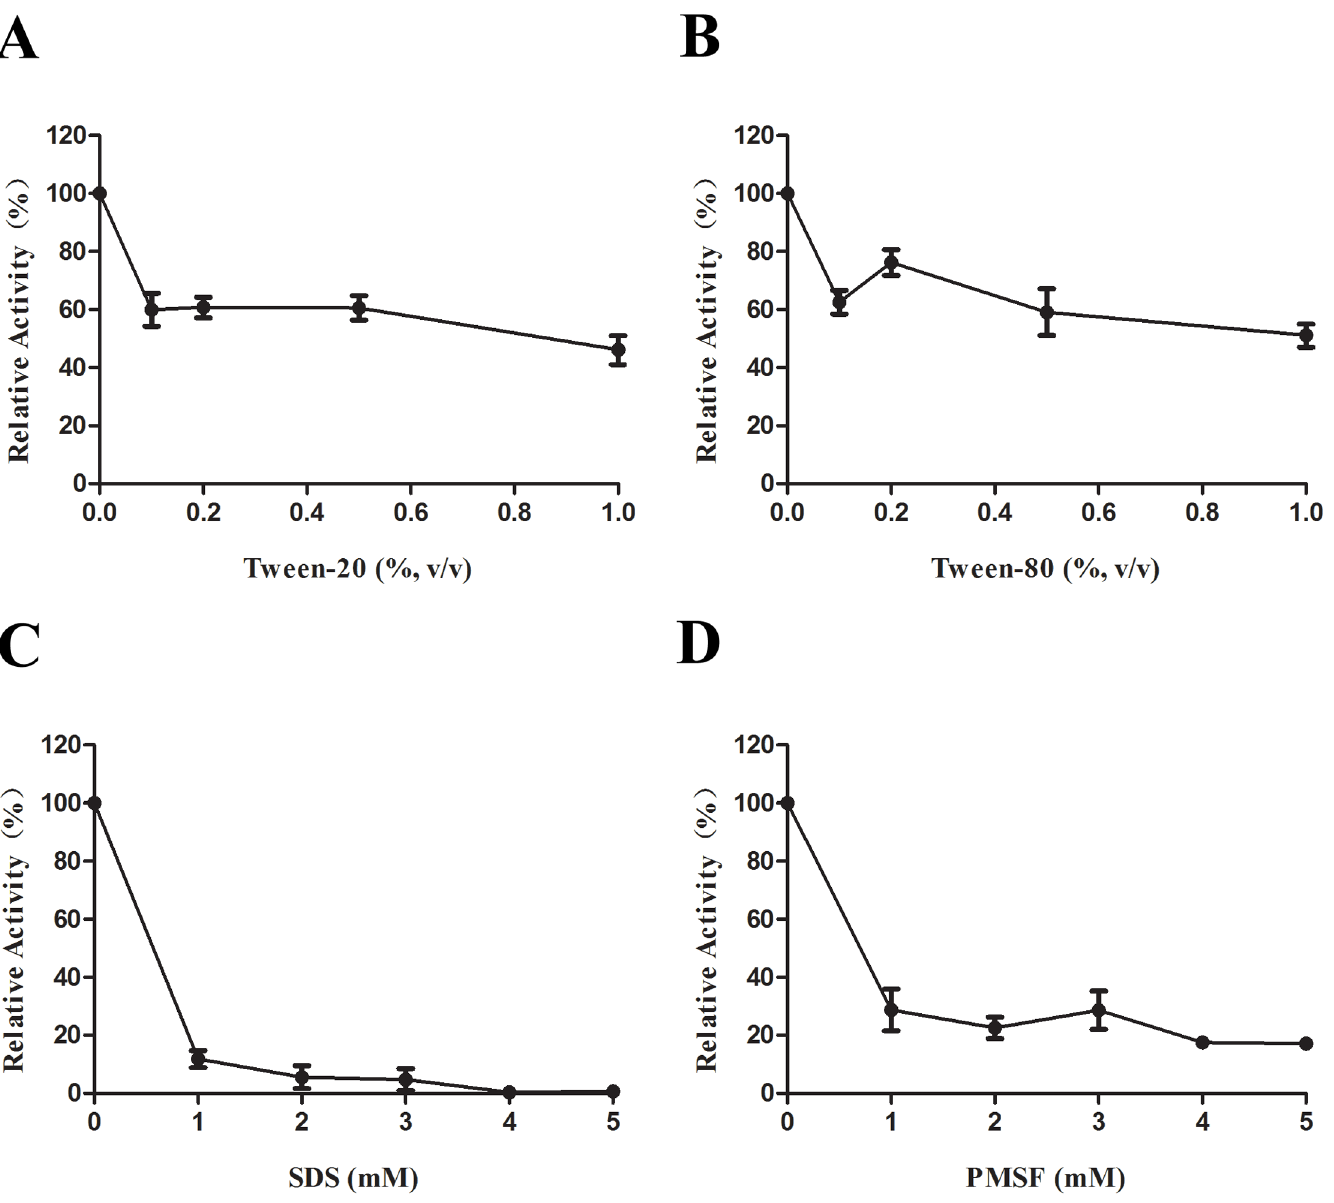
Fig 2. The effect of detergents on lipase activity of LipL. (A) Addition of Tween 20 at concentration ranging from 0% – 1% in the LipL lipase activity assays. (B) Addition of Tween 80 at concentration ranging from 0% – 1%. (C) Addition of SDS at concentration ranging from 0 mM – 5 mM. (D) Addition of PMSF at concentration ranging from 0 mM – 5 mM. Data represent the means ± SD of three independent